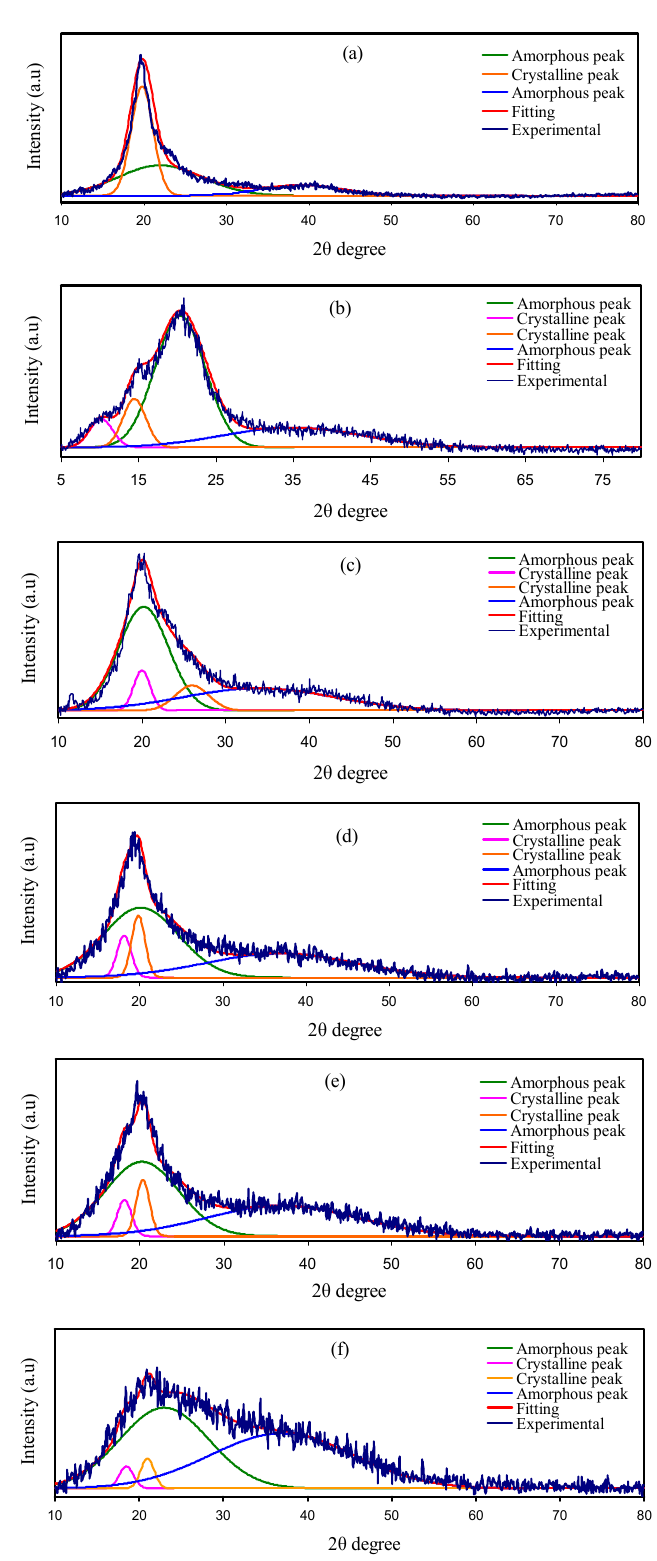
Figure 1. XRD pattern for ( a ) pure PVA, ( b ) pure CS, ( c ) CS:PVA blend, ( d ) CSPVMG1, ( e ) CSPVMG2, and ( f )